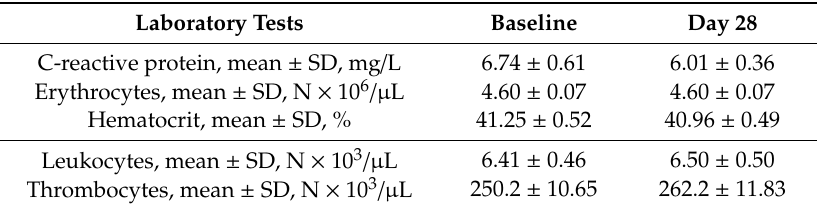
Table 3. Blood values of participating